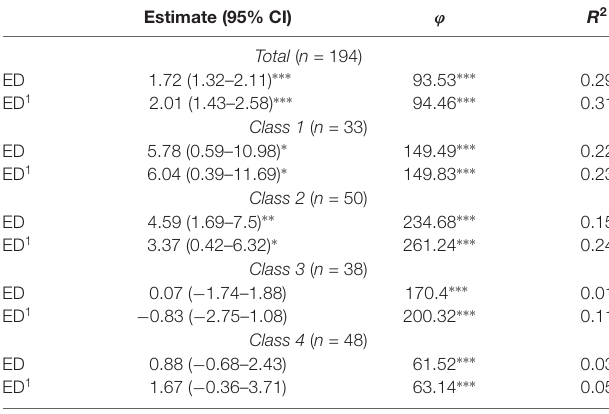
TABLE 2 | Beta regression analyses for the relationship between alcohol dependence and early drinking (ED) for all countries and by each country class. Estimate (95% CI)